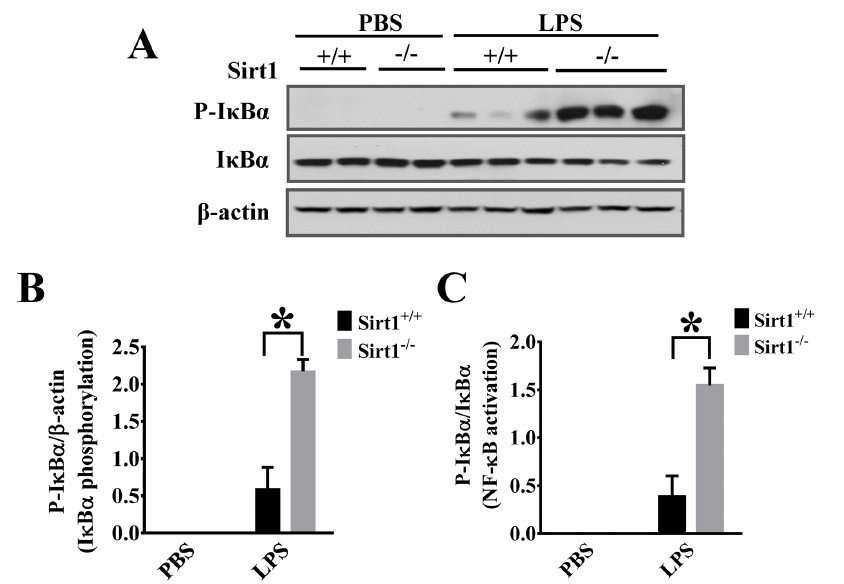
Figure 7. Sirt1 deletion enhances LPS-induced NF- k B activation. Kidney tissues were harvested 6 h after LPS challenge (n $ 7 mice/group). Kidney samples were then subjected to immunoblotting assay. I k B a phosphorylation and I k B a level were examined. (A) Representative blots of I k B a phosphorylation and total I k B a . (B, C) Densitometry analysis. *P , 0.05 versus Sirt1 + / + /LPS group.